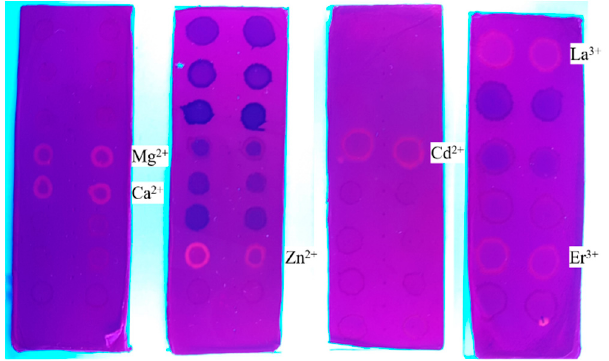
Figure 7. Photograph of ES nanofibers under UV light conditions.